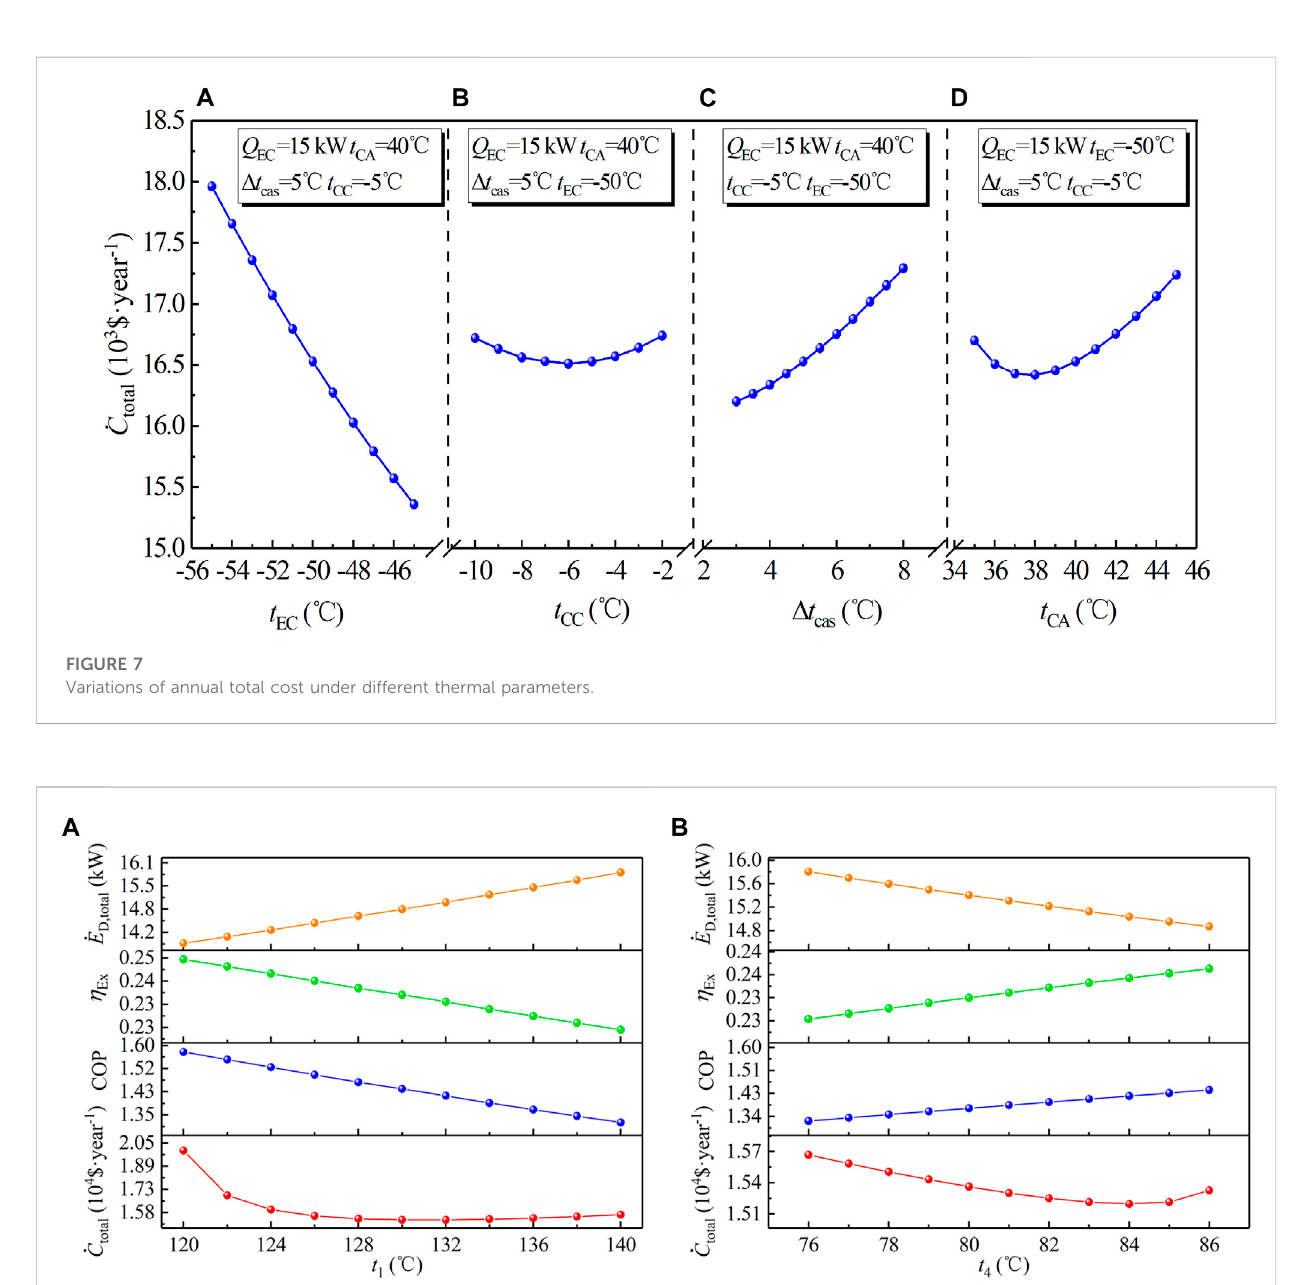
FIGURE 8 Variations of thermo-economic performances with generator